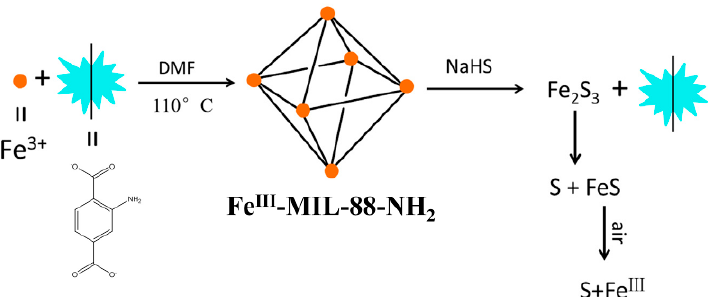
Figure 8. The synthesis and the turn-on fluoresence response of Fe III -MIL-88-NH 2 for H 2 S. Reproduced with permission from [87]. Copyright Elsevier B.V., New York, NY, USA, 2017.